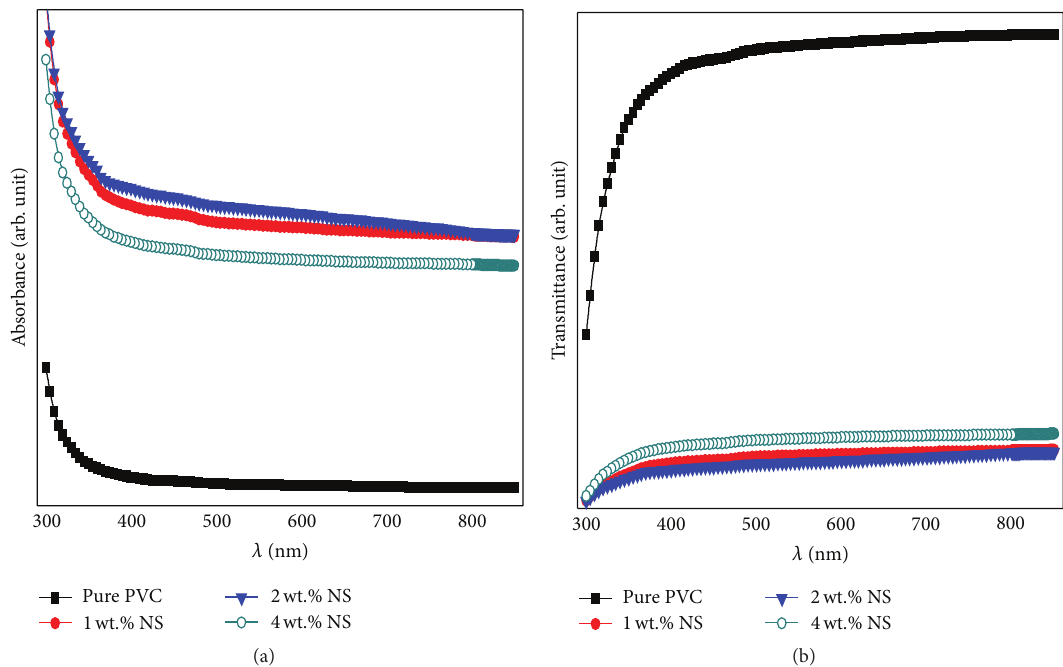
Figure 4: (a) The absorbance spectra for pure PVC and PVC-SiO 2 nanocomposite films. (b) The transmittances spectra for pure PVC and PVC-SiO 2 nanocomposite films.